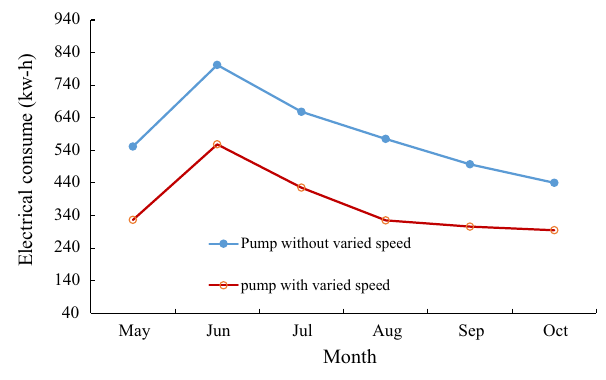
Fig. 9 Pump power consumption in different months for two modes of pump operation